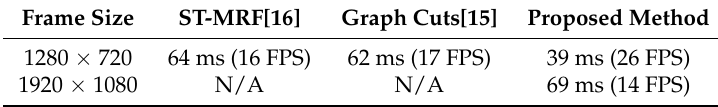
Table 5. Average per-frame running times for the preprocessing and tracking procedures. Values are expressed in milliseconds (ms) and frames per second (FPS). ST-MRF, spatio-temporal Markov random